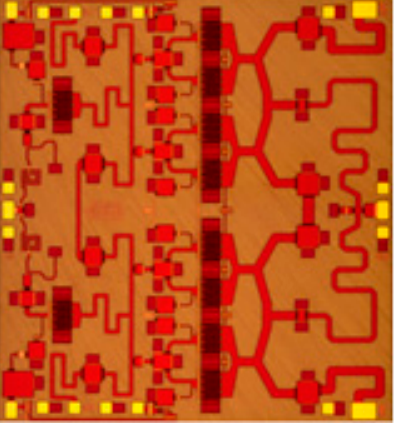
Figure 7. Photograph of X-band 40W power amplifier.